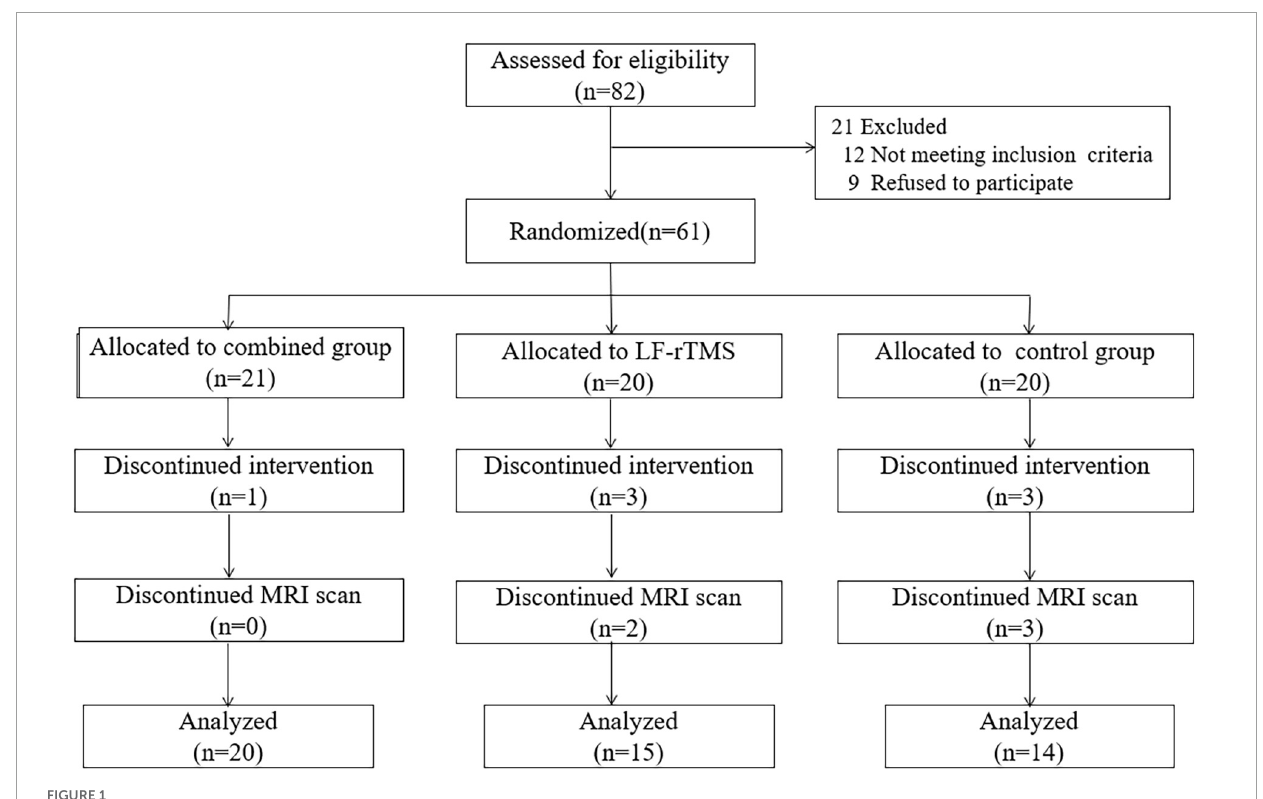
FIGURE1 The flow charts of the research design.